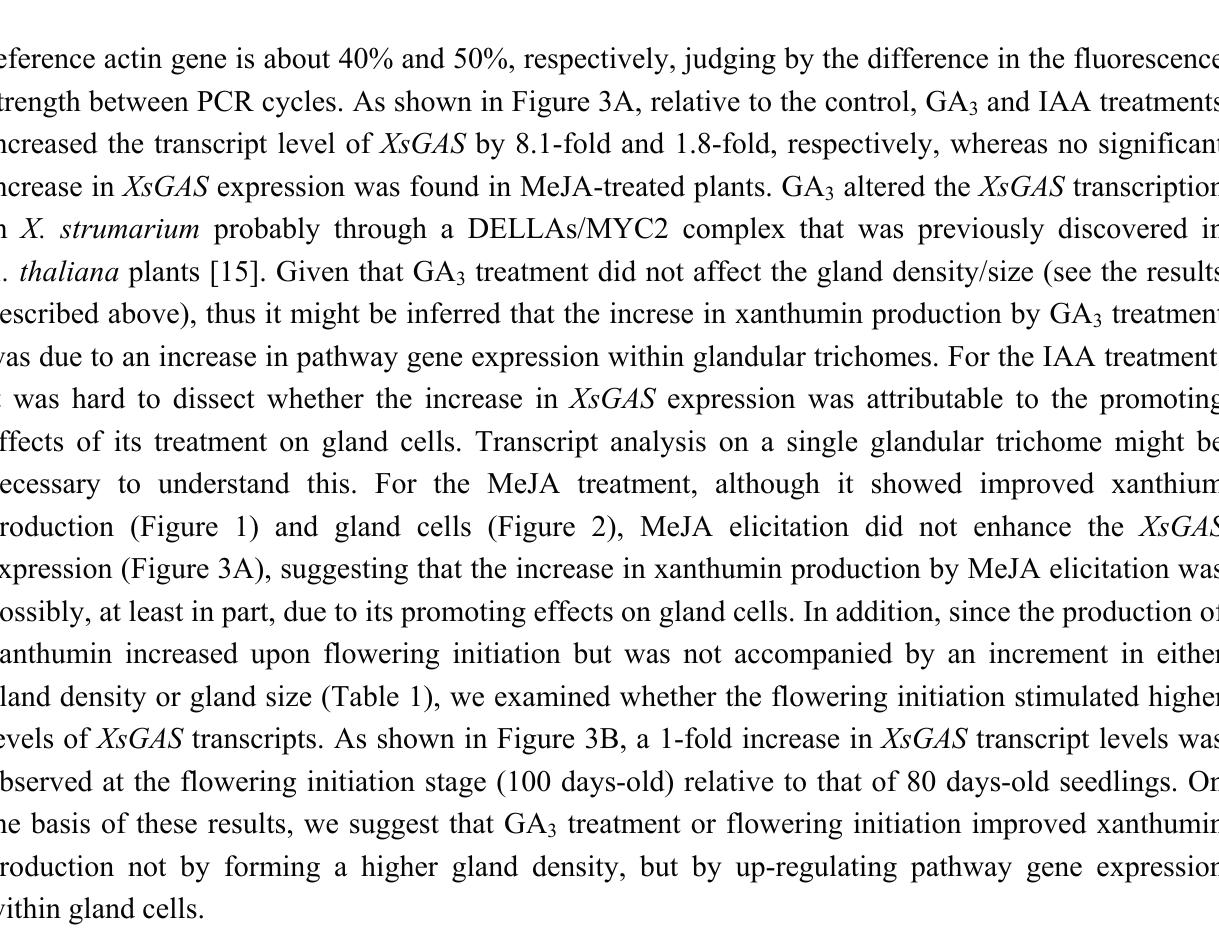
Figure 3. The effects of flowering initiation and phytohormonal treatments on XsGAS expression in X. strumarium L. young leaves. Data presented are representative of two independent experiments. Error bars indicate the range of possible value on SD of replicate values. Asterisks indicate sisgnificant differences. * p < 0.05, ** p < 2 −ΔΔ C T